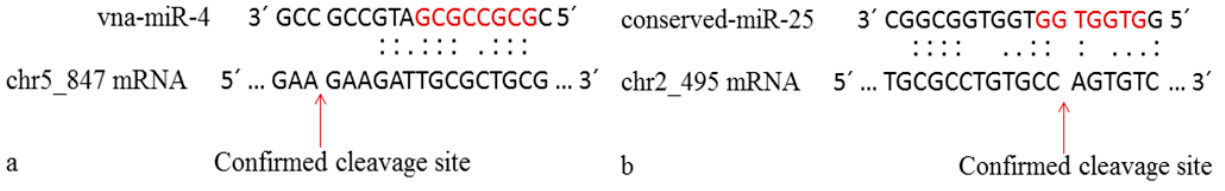
Figure 4. Predicted hop target clustering of selected hop transcripts by their biological process according to enriched gene ontologies; the values represent the number of selected milRNA targets in each enriched GO annotation.